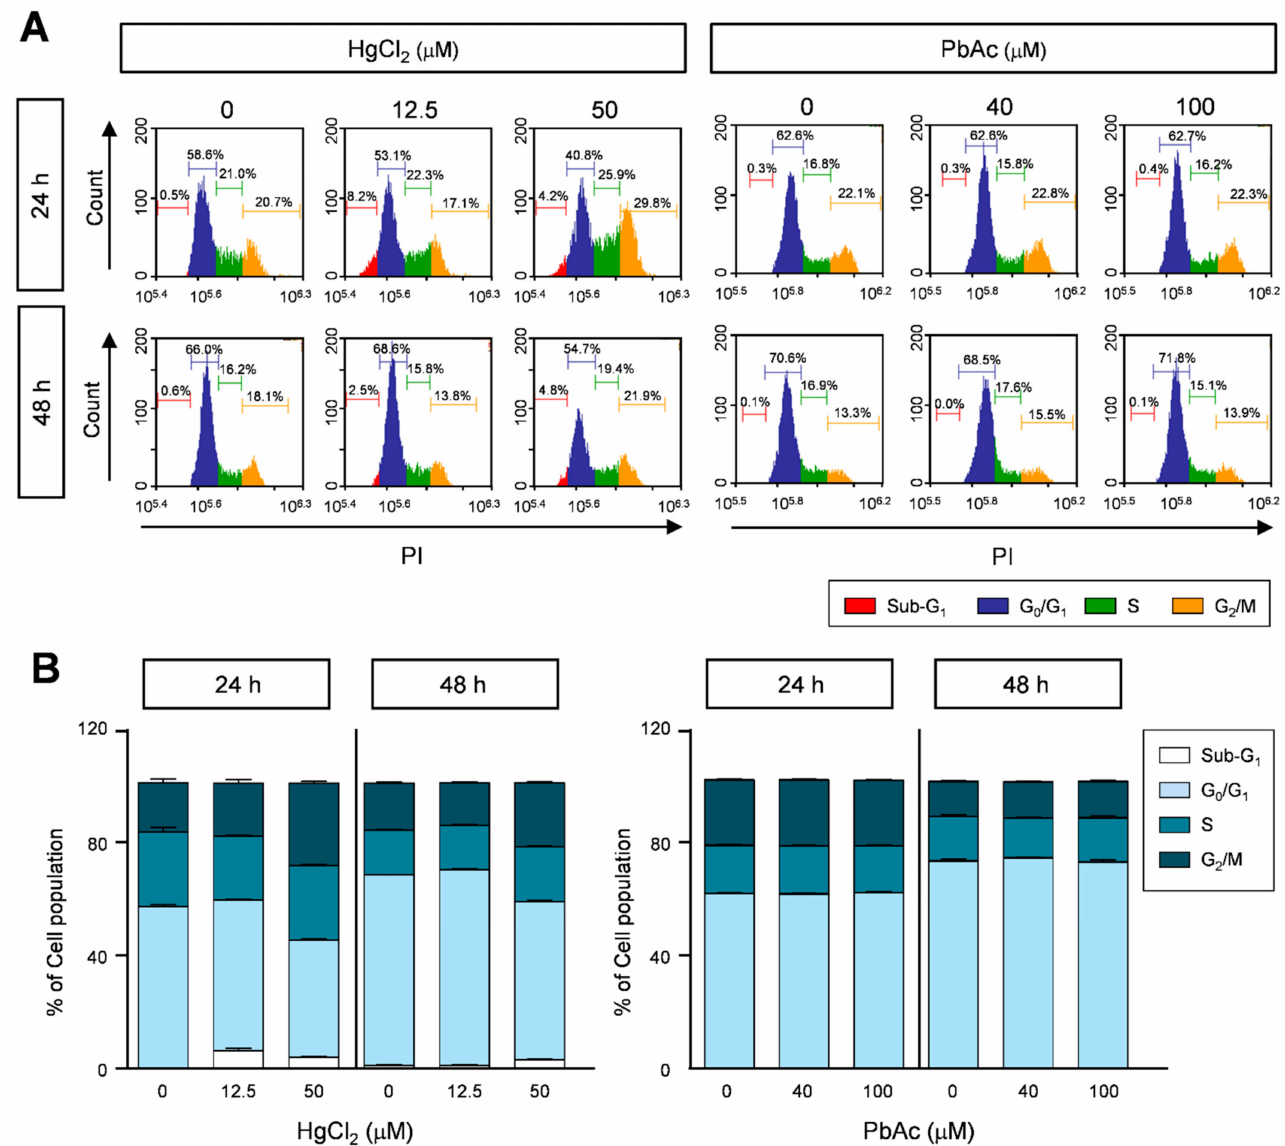
Figure 3. Cell cycle progression in heavy metals treatment in MRC5 cells. ( A ) The heavy metals-treated MRC5 cells were stained with propidium iodide (PI), and the cell cycle was measured using FACS analysis. ( B ) The percentages of population in the sub-G 1 , G 0 /G 1 , S, and G 2 /M phases are represented as the mean ± S.E.M. of three independent experiments (n = 6), each performed in